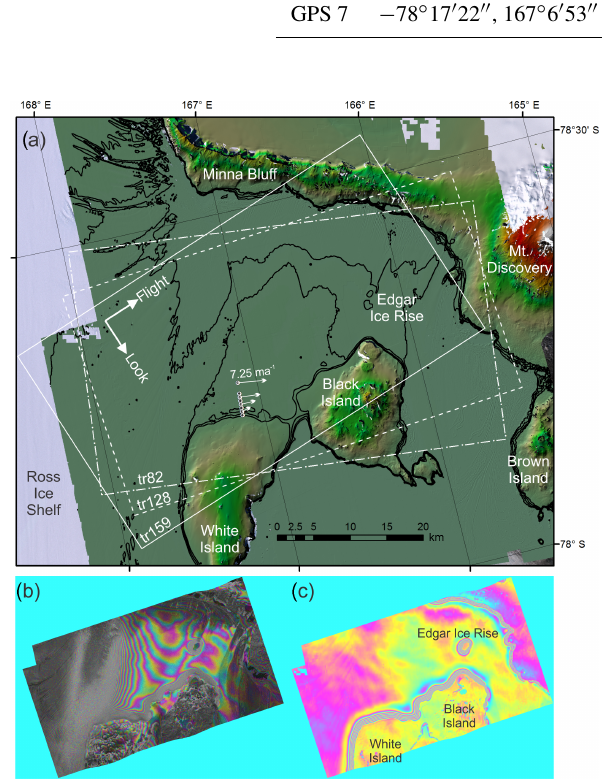
Figure 1. (a) Digital elevation model of the investigation area based on WorldView-1/2 stereo satellite imagery (October 2010– November 2011) in the southern McMurdo Sound. TerraSAR-X image frames of three descending satellite tracks are shown. On the ice shelf a few contour lines at 10m separation are plotted as well as average displacements vectors for the measurement profile south of White Island. One original and one fully processed inter- ferogram (t128) are shown in (b) and (c) , respectively (DInSAR combination 9, Table